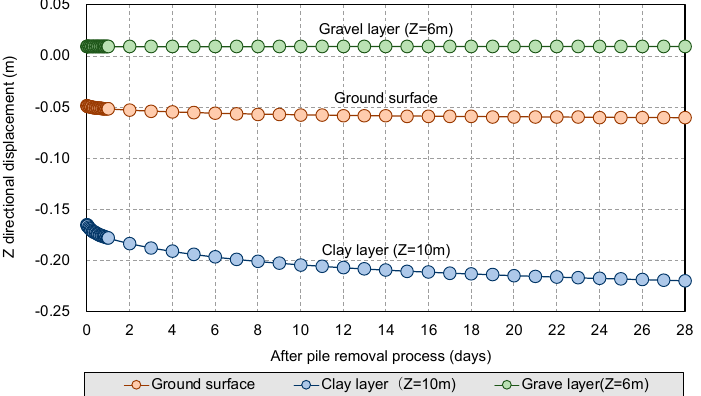
Figure 9. Subsidence of the surrounding ground after the formation of two extraction holes of removed piles.